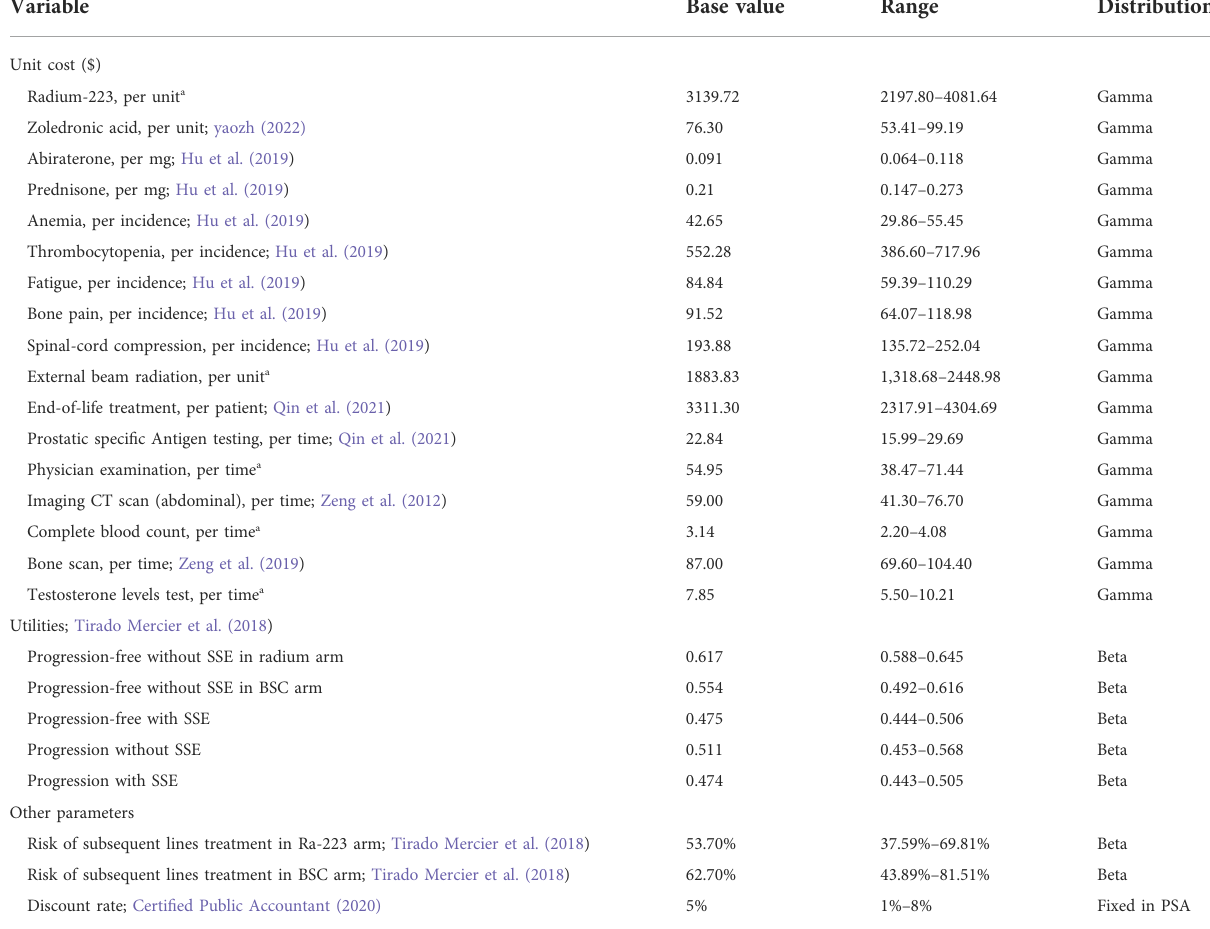
TABLE 2 Unit costs, utilities, and other parameter inputs used in the model.